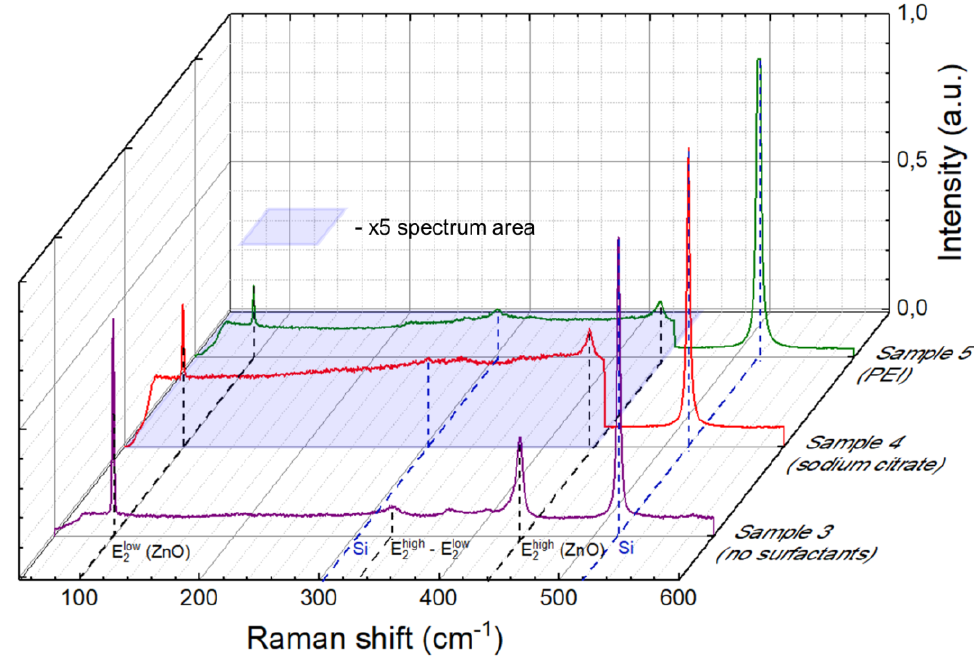
Figure 2. Raman spectra of: Sample 3 without surfactants (violet spectrum), Sample 4 using sodium citrate (red spectrum), Sample 5 using PEI (green spectrum). The signal intensity of Samples 4 and 5 was increased five-fold in the region of 50 – 440 cm − 1 for visibility.